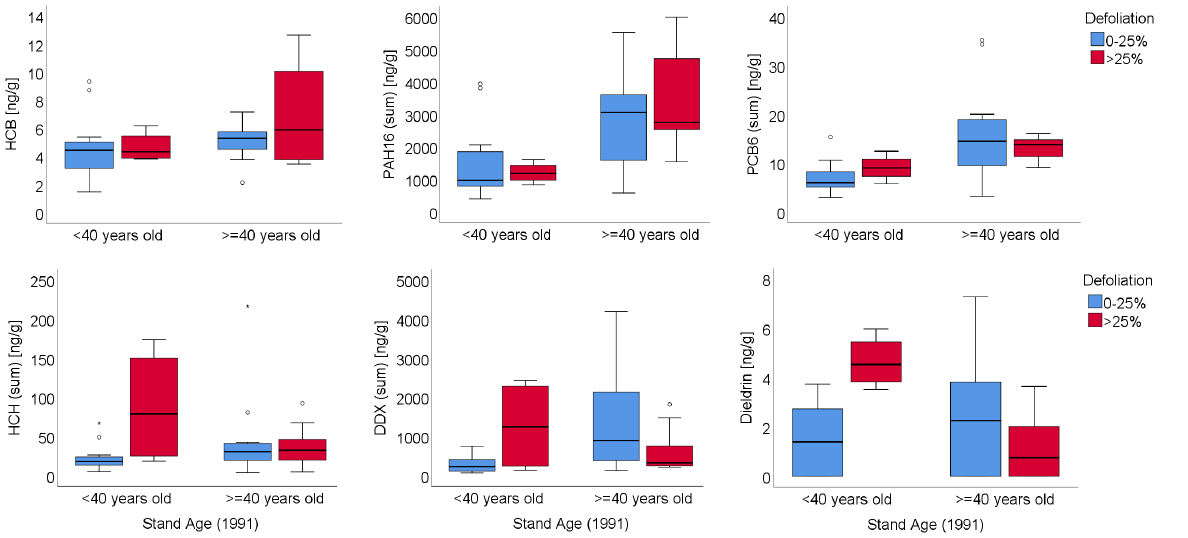
Figure 6. Box plots of the contents of HCB, PAH 16 , PCB 6 , HCH, DDx and Dieldrin in the humus layers of pine stands differentiated according to stand age and crown condition (percentage needle loss); ° outliers, * extreme